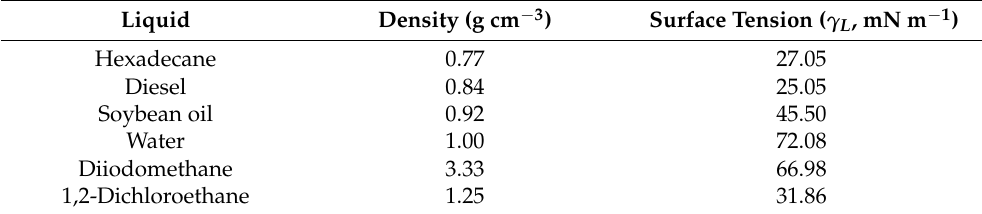
Table 1. Densities and surface tensions of the test liquids